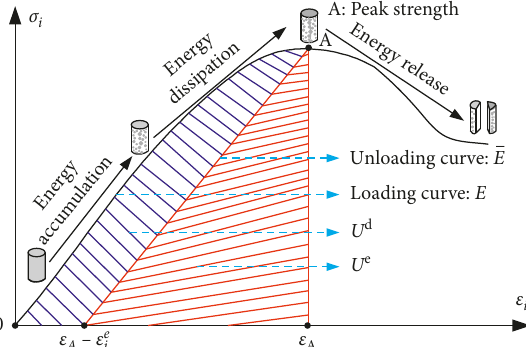
Loading curve: E